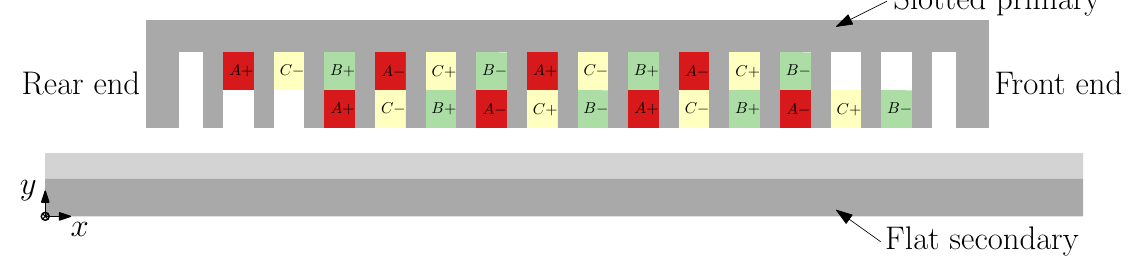
Figure 1. Analyzed linear induction motor (LIM)